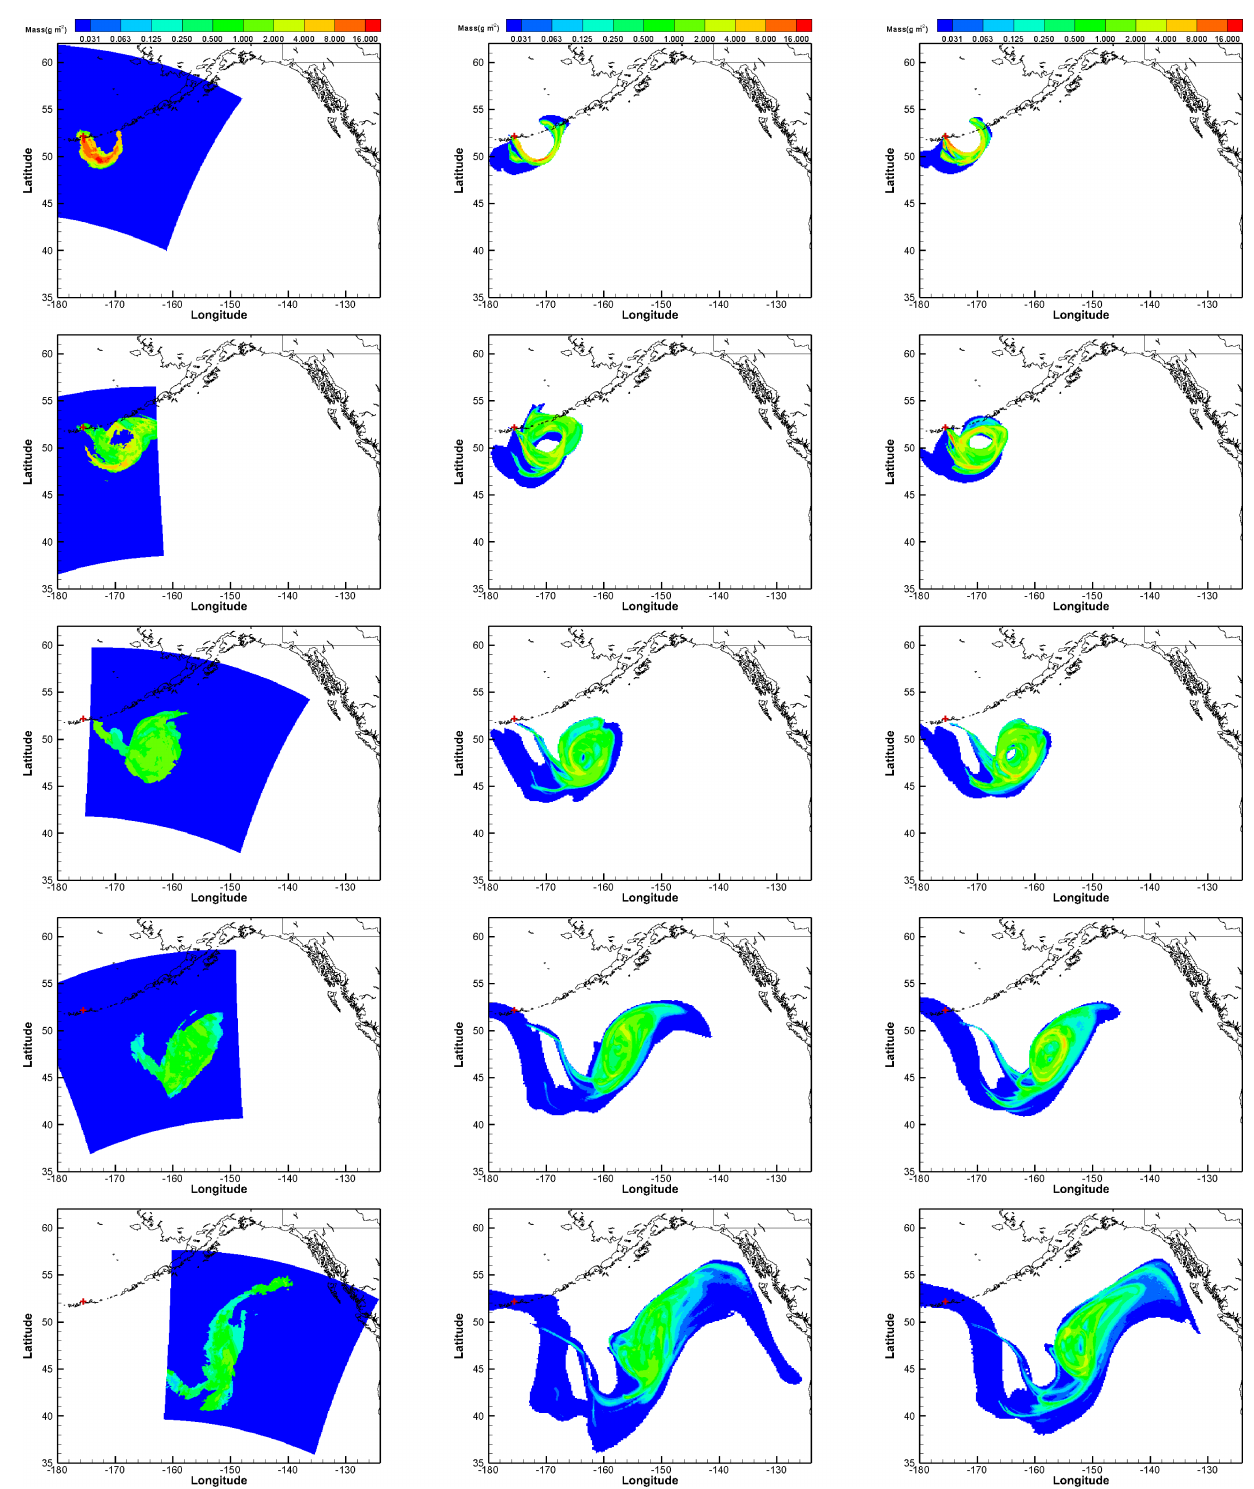
Figure 5. Volcanic ash mass loadings from MODIS (left) and HYSPLIT simulations with GDAS (center) and ECMWF (right) from top to bottom by observation time (see Table 1 for detail). “ + ” shows the location of the Kasatochi volcano (52.1714 ◦ N, 175.5183 ◦ W). The white areas indicate regions outside the satellite granules for MODIS observations. For HYSPLIT simulations, the white areas indicate zero mass loadings in order to reveal the ash cloud boundaries. The ash release rates for the HYSPLIT simulations were obtained by assimilating granules G1, G2, and G3. In the inverse modeling, only ash pixels were used, and the model mass loadings are calculated by integrating over three layers centered at the cloud top